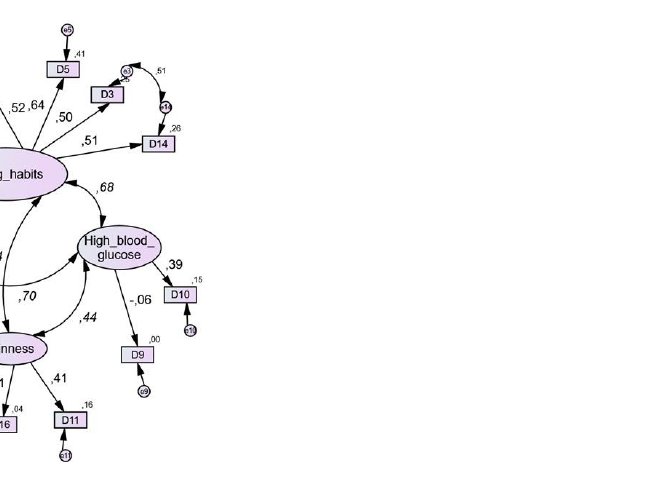
Table 2. Characteristics of patients with type 1 diabetes mellitus (T1DM) according to the score on the Diabetes Eating Problem Survey - Revised Version (DEPS-R) (cut-off score 20) (N = 103). Characteristics